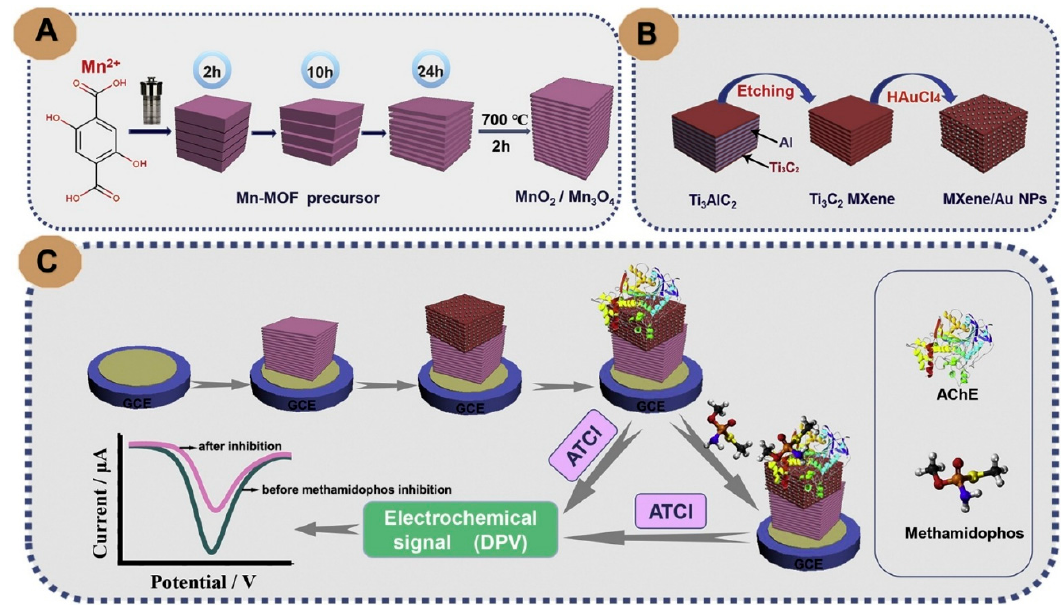
Figure 5. Illustration of the formation of MnO 2 /Mn 3 O 4 composite ( A ), MXene/Au NPs ( B ), the fabrication process of AChE-Chit/MXene/Au NPs/MnO 2 /Mn 3 O 4 /GCE biosensor for methamidophos assay ( C ) (reproduced with permission from reference [74]).